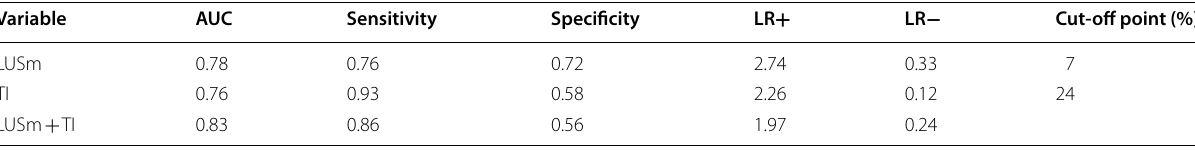
AUC, area under the ROC curve; LR